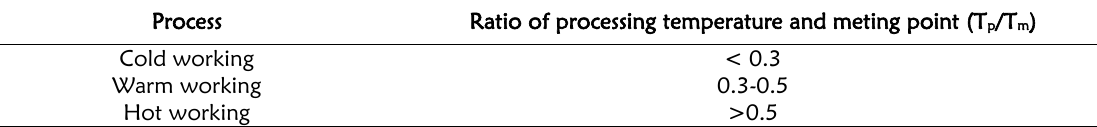
Table 1: Temperature range for various process